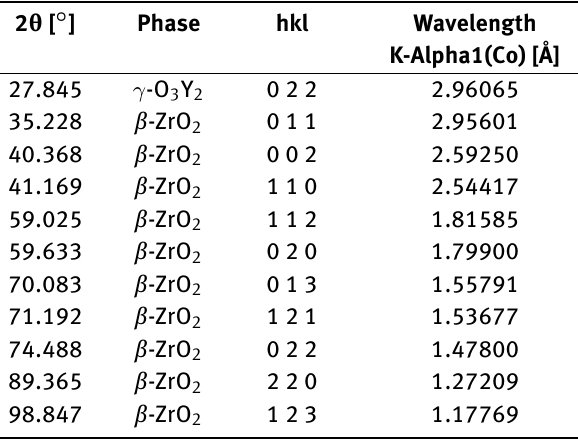
Table 1: Phase composition analysis of the reference sample